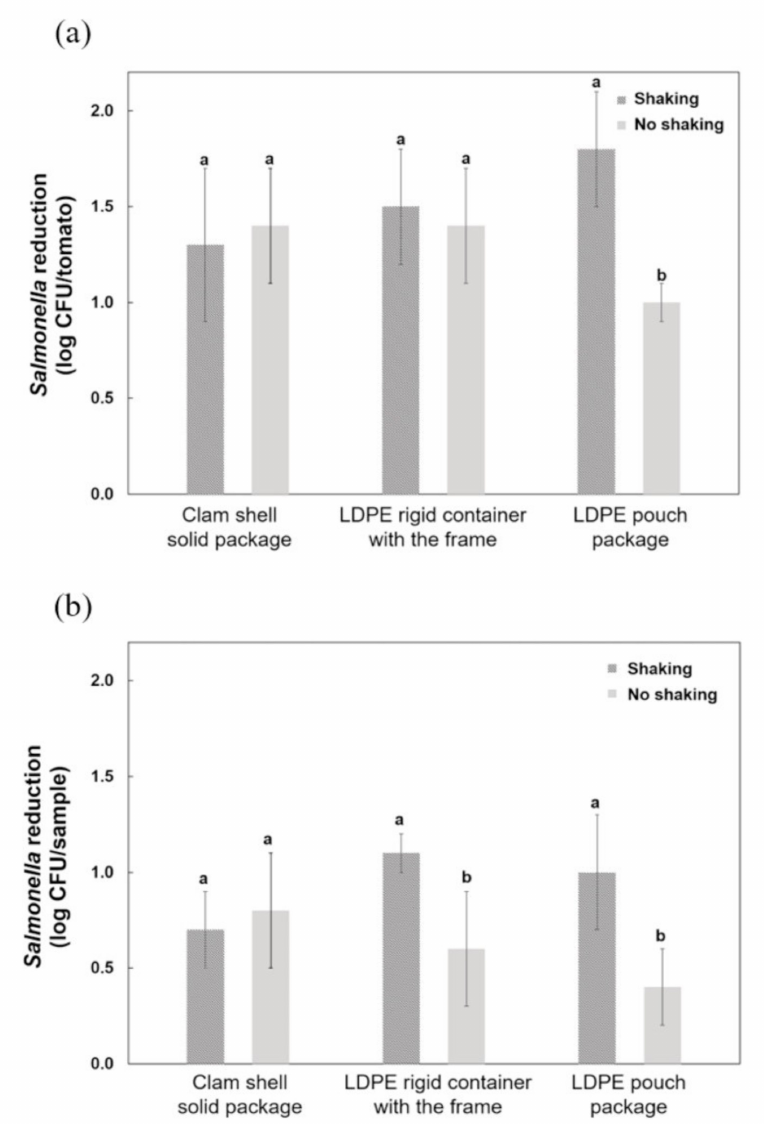
Figure 2. The effect shaking has under DBD ADCP treatment on ( a ) grape tomatoes ( b ) slices of romaine lettuce, red cabbage, and carrot with clamshell solid packages, LDPE rigid containers and the LDPE pouch package. The letters indicate significant differences at p < 0.05. Reprinted with permission from ref. [52]. Copyright 2022